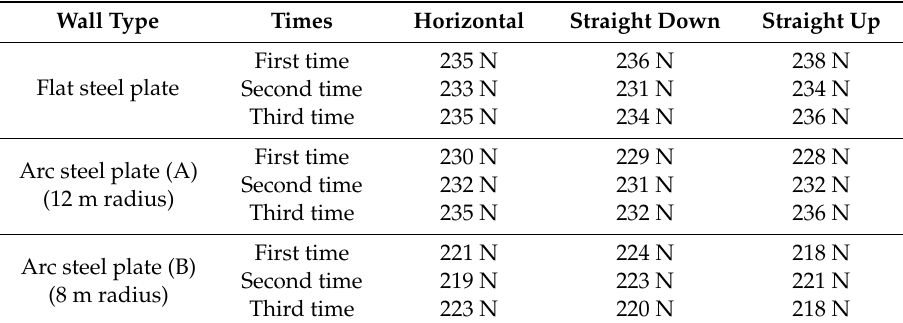
Figure 4. Magnetic wheel adsorption test. ( a ) Horizontal direction; ( b ) vertical downward direction; ( c ) vertical upward direction.